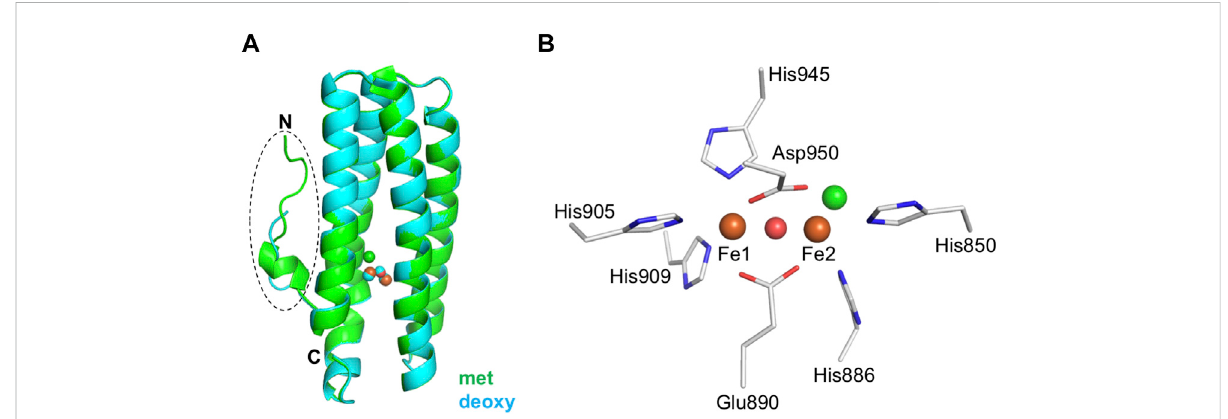
FIGURE 2 Structural features of the hemerythrin domain of the bacterial hemerythrin domain-containing sensor DcrH. (A) Structural comparison of the hemerythrin domain in its met (green, PDB entry 2AWY) and deoxy (cyan, PDB entry 2AWC) forms. The N-terminal loop is circled. (B) An enlarged depiction of the non-heme diiron center in its met form (PDB entry 2AWY). Iron atoms and bridging oxo are shown as orange and red spheres, respectively. Chloride (green sphere) is bound to Fe2 in the non-heme diiron